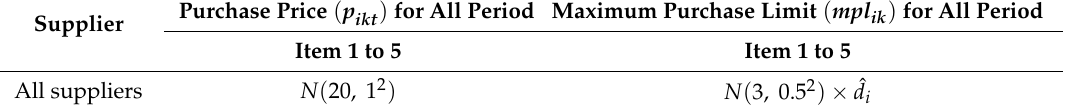
Table 6. Input parameters for each